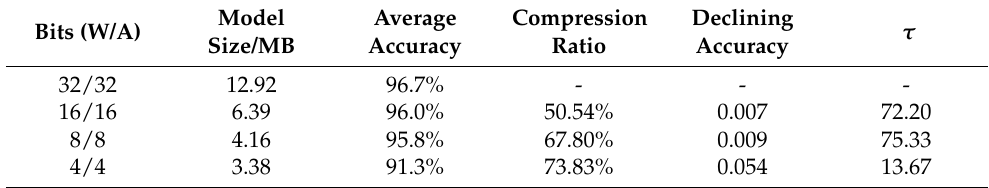
Table 4. Source number estimation network quantification results.